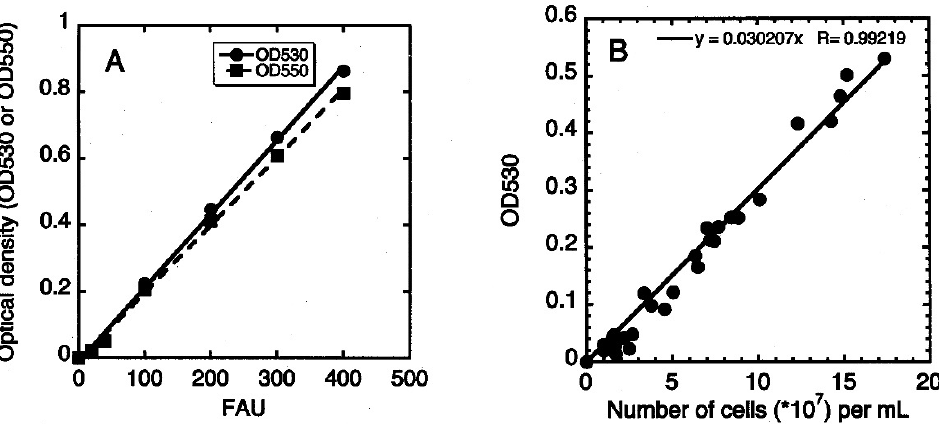
Figure 3. Determination of cell density by turbidity measurements. ( A ) Correlation between the formazine turbidity (FAU) and the optical densities at 530 nm and 550 nm. ( B ) Correlation between the number of cells per volume and the optical density at 530 nm.